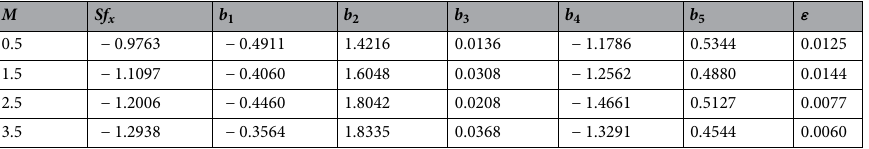
Table 5. Numerical findings of Nn x with velocity slip ( L varying values of influencing parameters are highlighted with bold numbers.